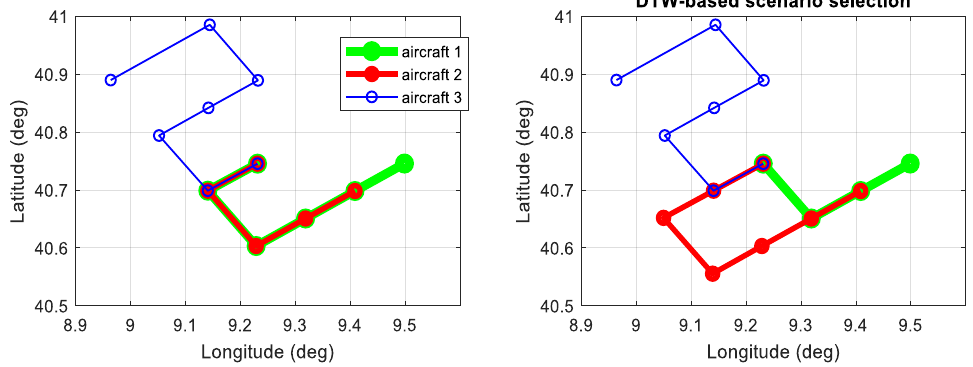
Figure 3. DTW-based selection from equivalent scenarios.